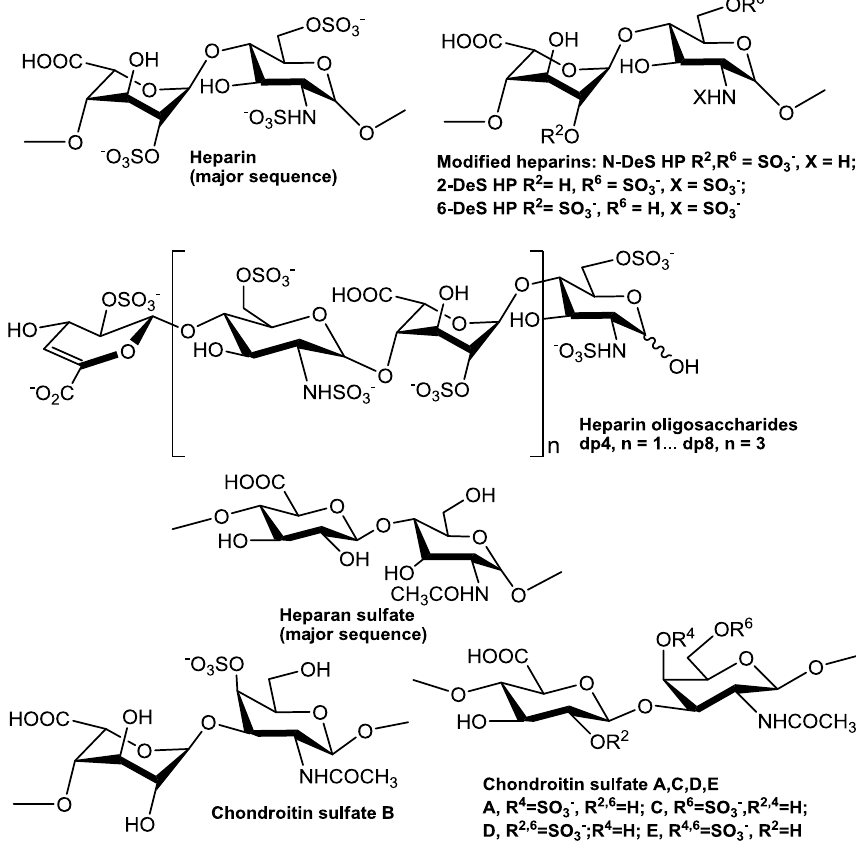
Figure 1. Chemical structures of heparin, heparin-derived oligosaccharides, chemically modified heparins, and other